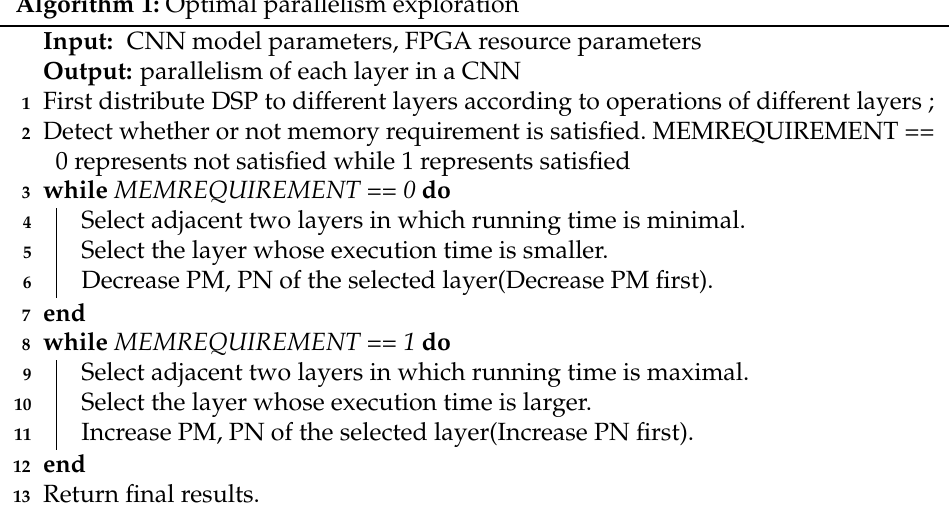
Algorithm 1: Optimal parallelism